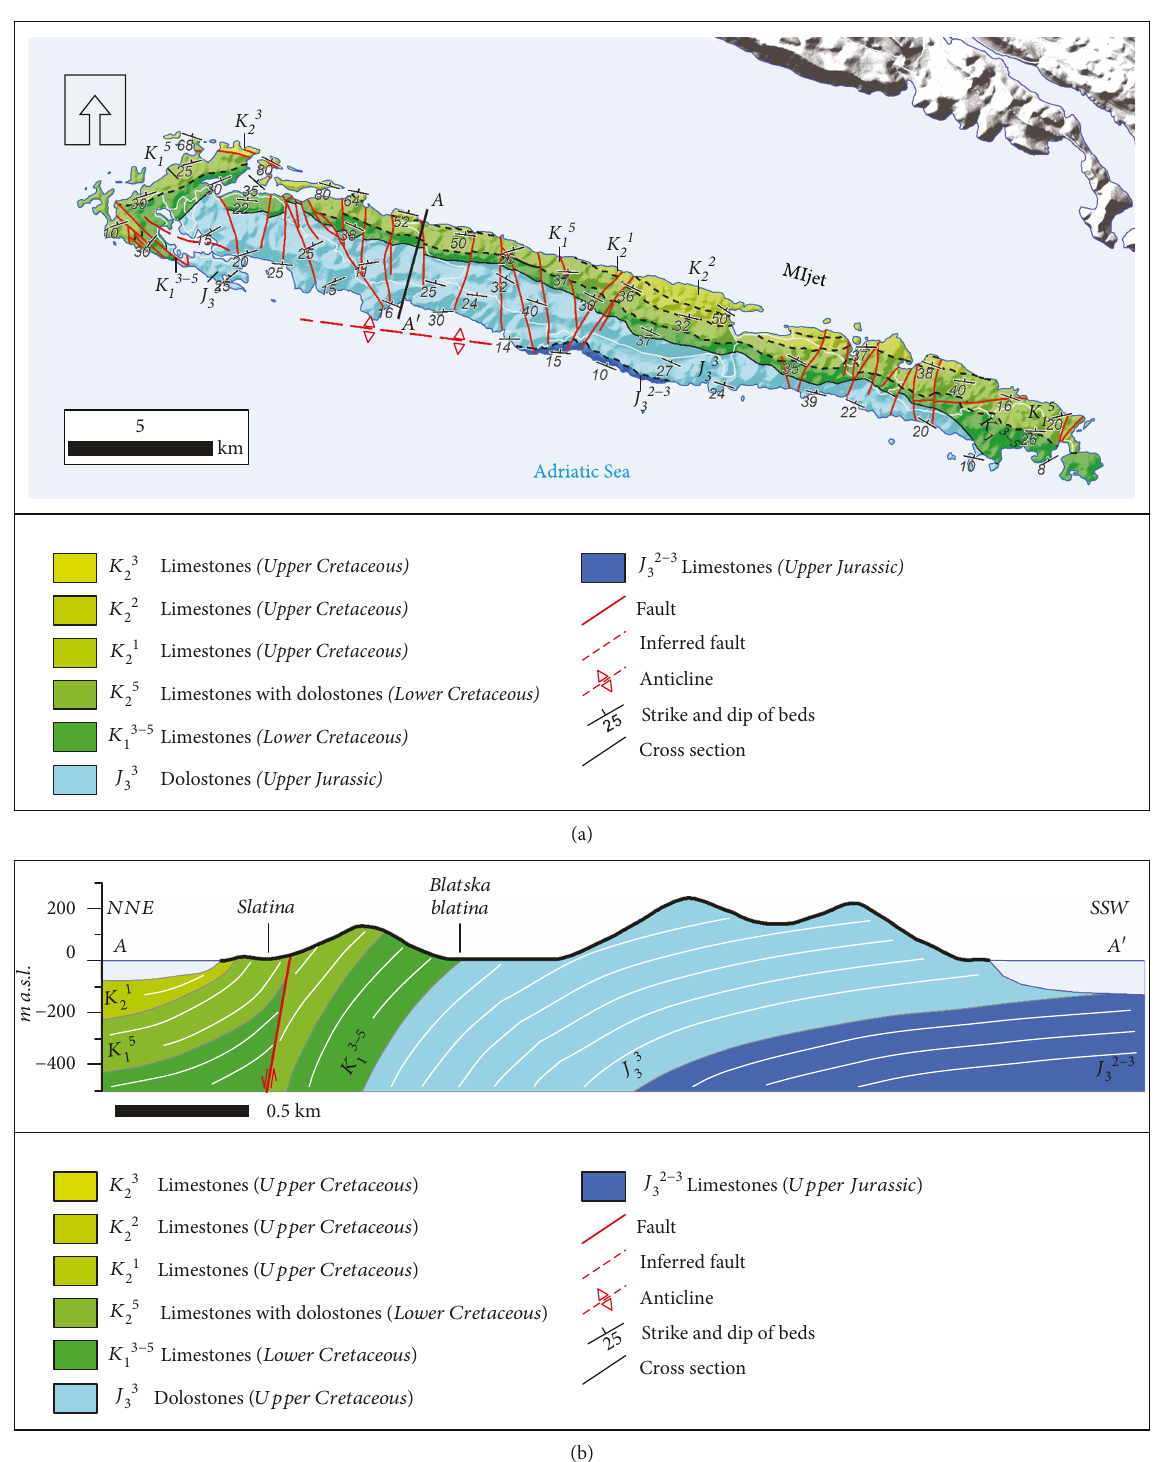
Figure 2: Geological map (a) and cross section (b) of the island of Mljet (modi fi ed after [19,